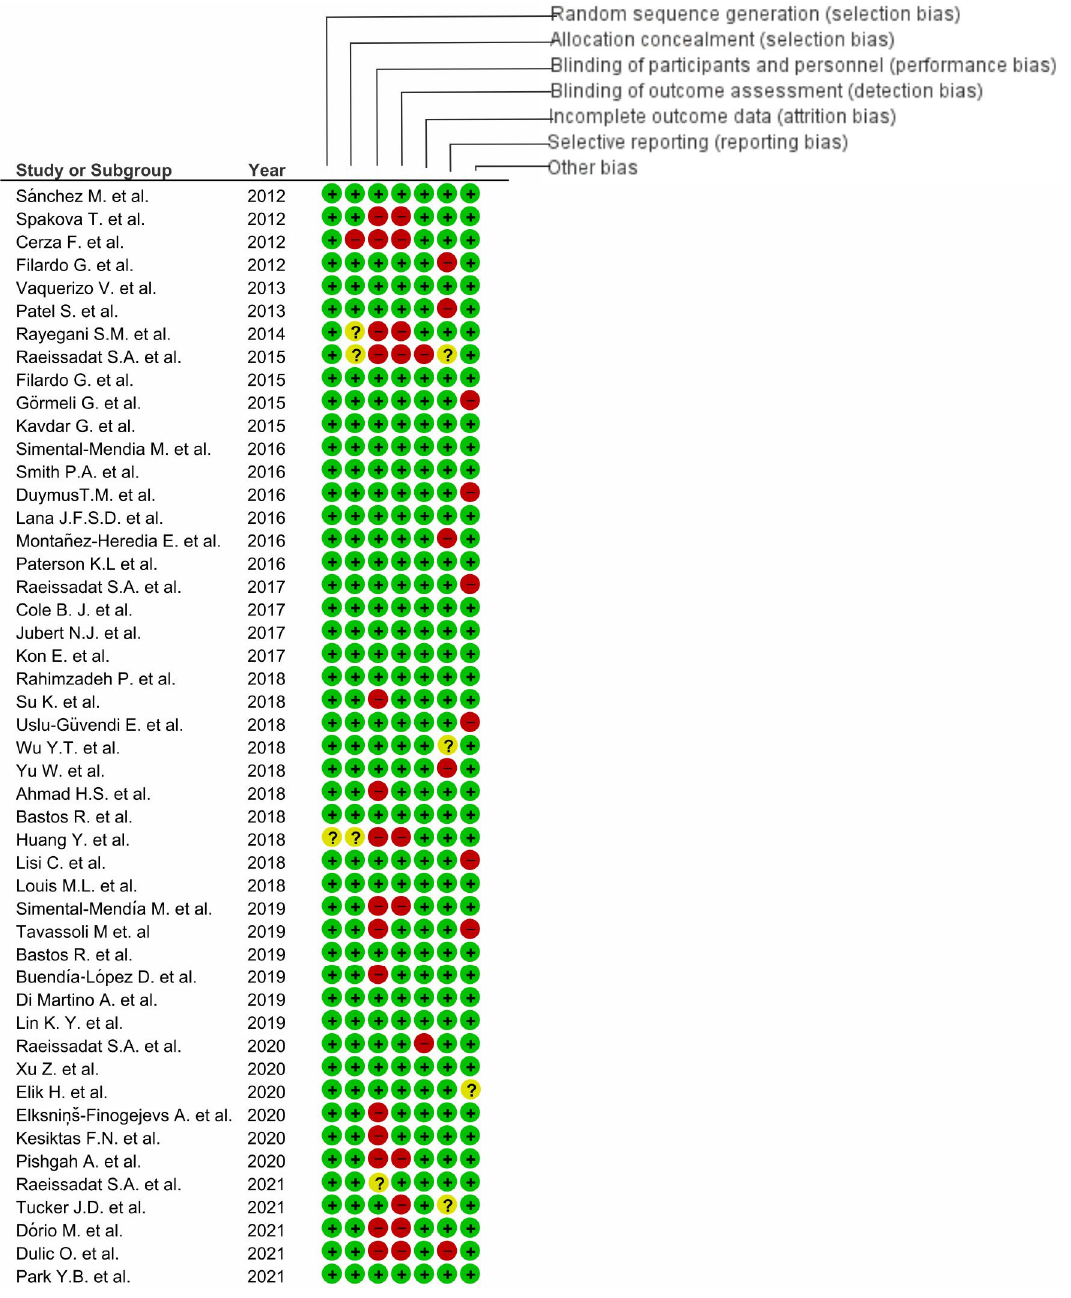
Figure 8. Risk of bias analysis for PRP application in osteoarthritis ( , low risk of bias; , un- clear risk of bias; , high risk of bias).